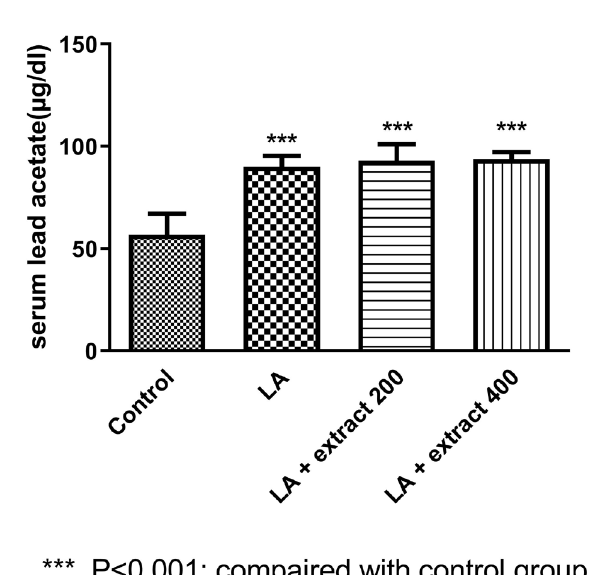
FIGURE 1 - Effect of Rheum ribes extract (ext) on serum lead acetate levels in rats treated with lead acetate (LA).